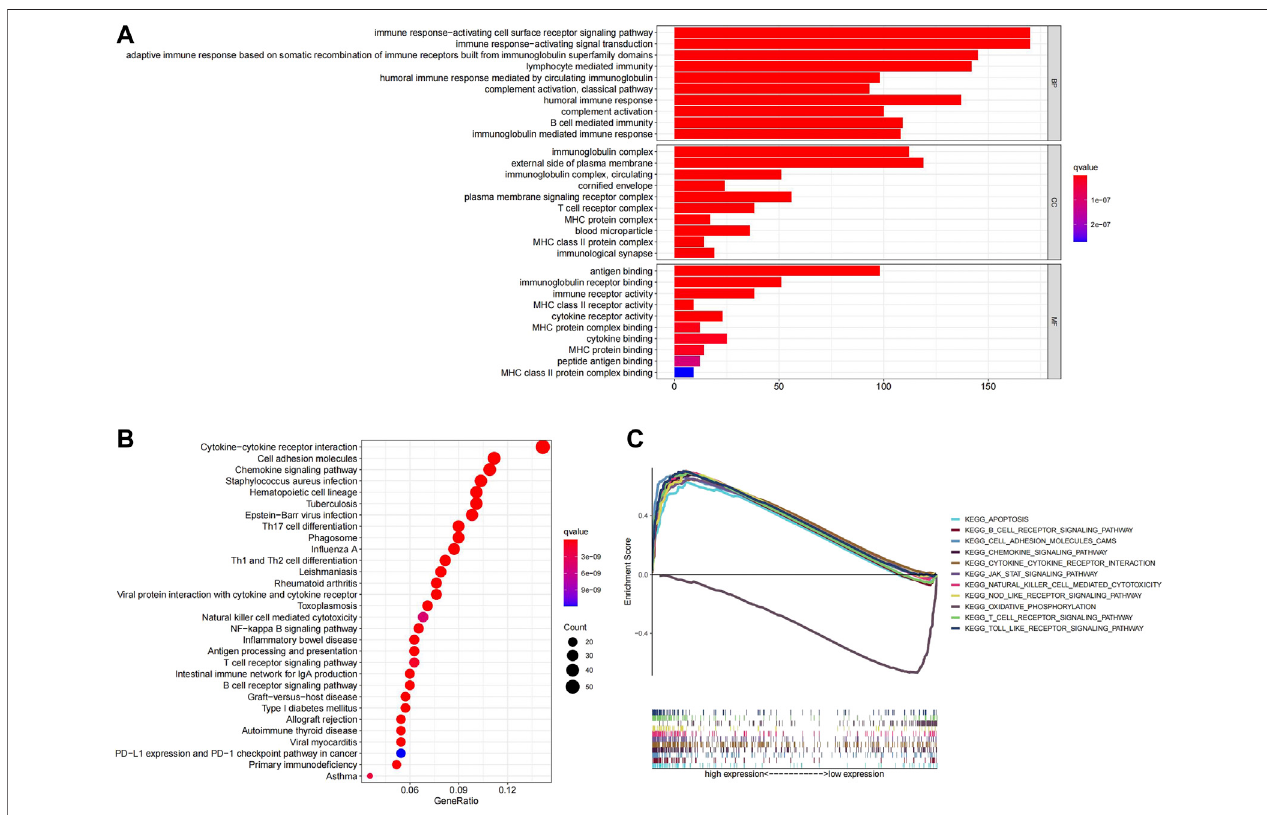
FIGURE 6 | (A) Top ten GO terms were selected for visualization. (B) Twenty KEGG pathways were visualized. (C) GSEA analysis, the differences in enrichment pathways between high- and low-risk groups were